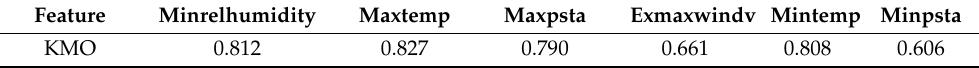
Table 1. KMO test